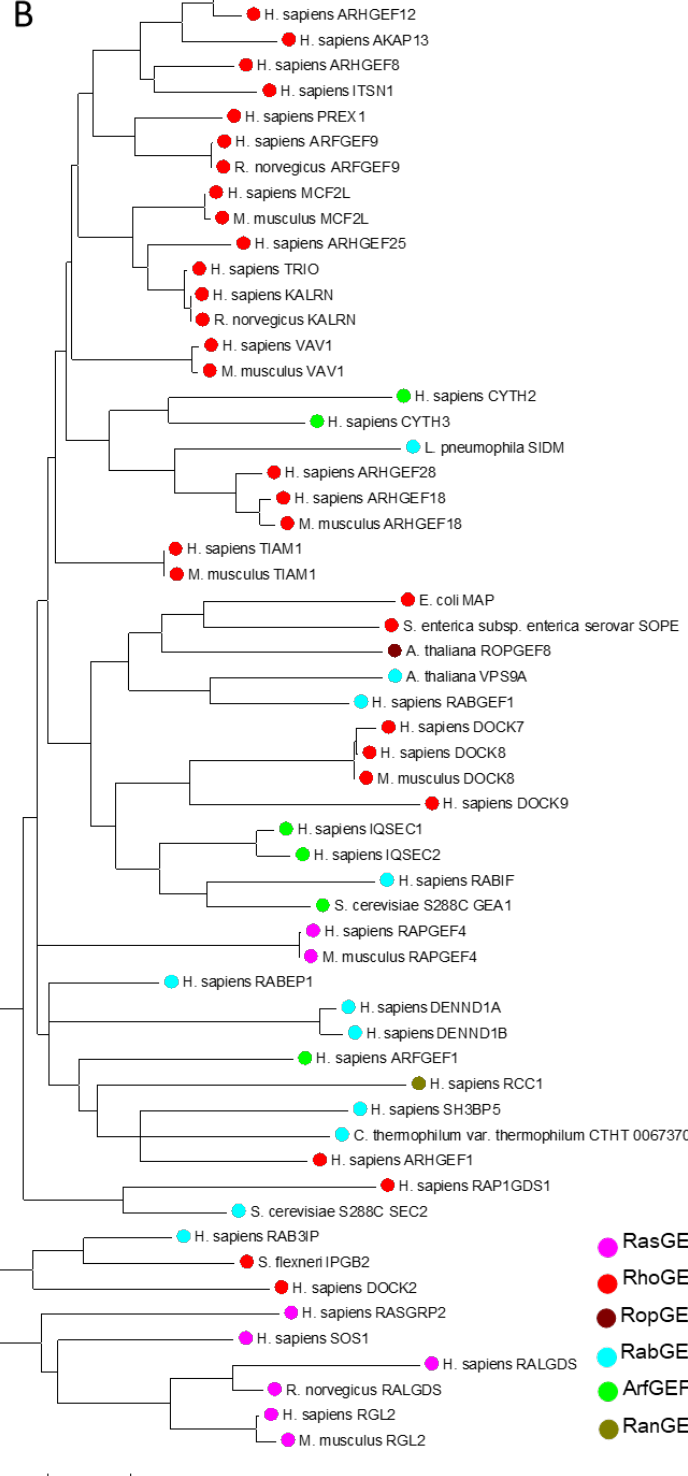
Figure 2. Schematic representation of GEF architecture: ( A ) Representative GEFs for the Ras, Rab, Arf, Ran, and Rho families are shown. Domains are defined by SMART (http://smart.embl-heidelberg.de) or Pfam (https://pfam.xfam.org/). The pink and green bars depict low complexity and coiled coils, respectively. ( B ) Molecular phylogenetic analysis of GEFs by the maximum likelihood method. Evolutionary analyses were conducted in MEGA7 [19]. GEF domains have been aligned to produce this phylogenetic tree.